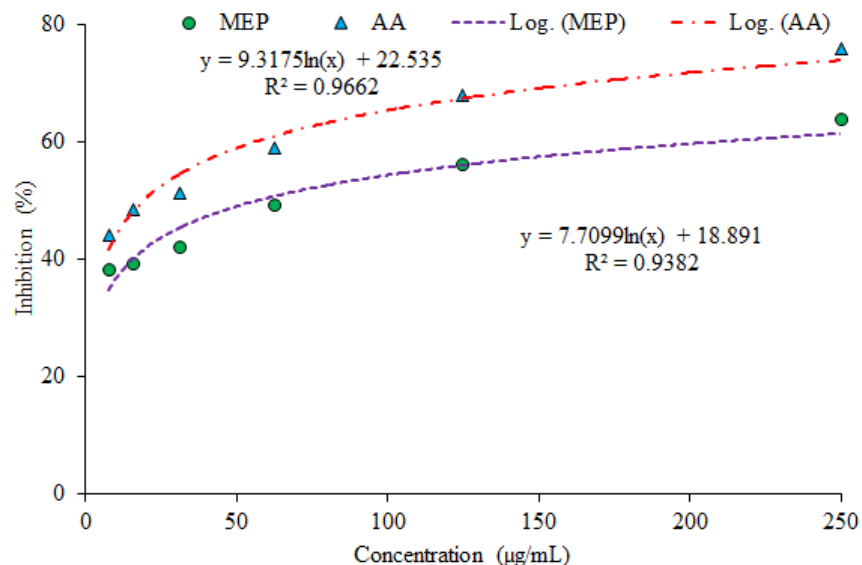
Figure 3. Percentage scavenging at various concentrations through reducing power assay (RPA) (MEP–Methanol extract of plants; AA–Ascorbic acid).